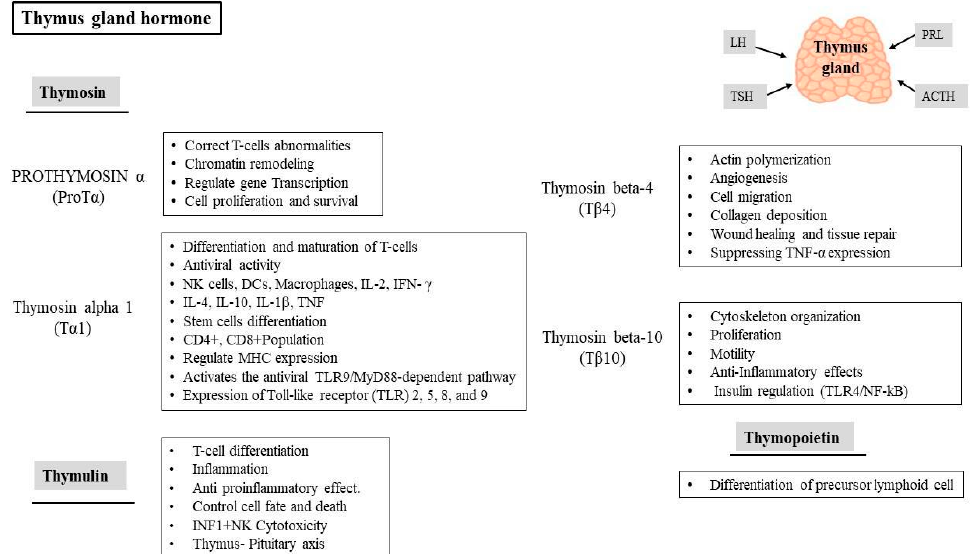
Figure 4. Types and roles of thymus gland hormones. The thymus produces immunoregulating hormones such as thymosin, and its family includes prothymosin alpha, thymosin alpha 1, thymosin beta-4 and thymosin beta-10, thymuline, and thymopoietin.